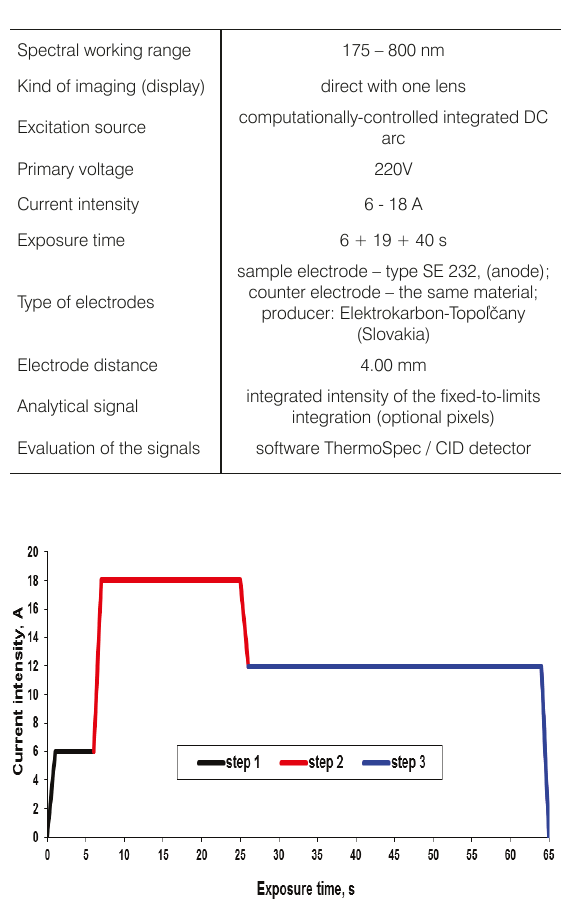
Figure 1. DC arc exposure program, optimized arcing